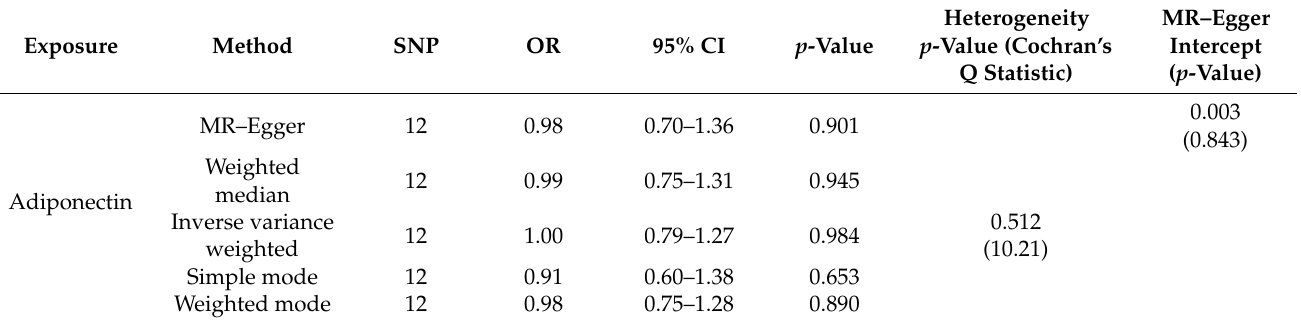
Table 2. The results of a Mendelian randomization analysis that looked at the relationship between circulating adiponectin levels and the risk of ankylosing